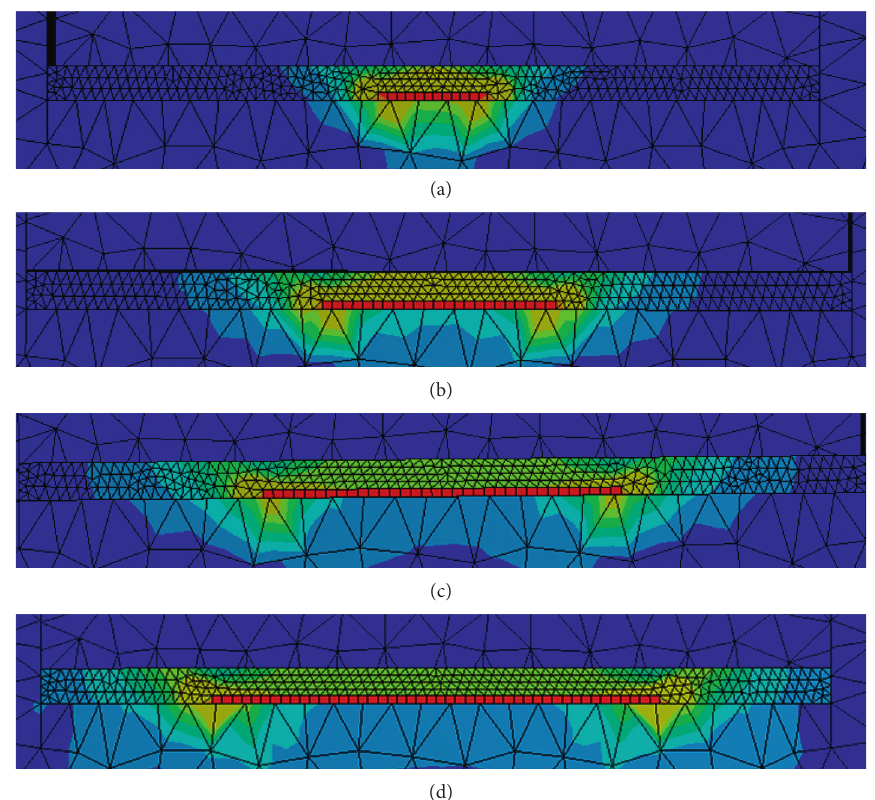
Figure 4: Comparison of stress concentration under different groove conditions: (a) 1 mm 2 , (b) 4mm 2 , (c) 9mm 2 , and (d) 16mm 2 .